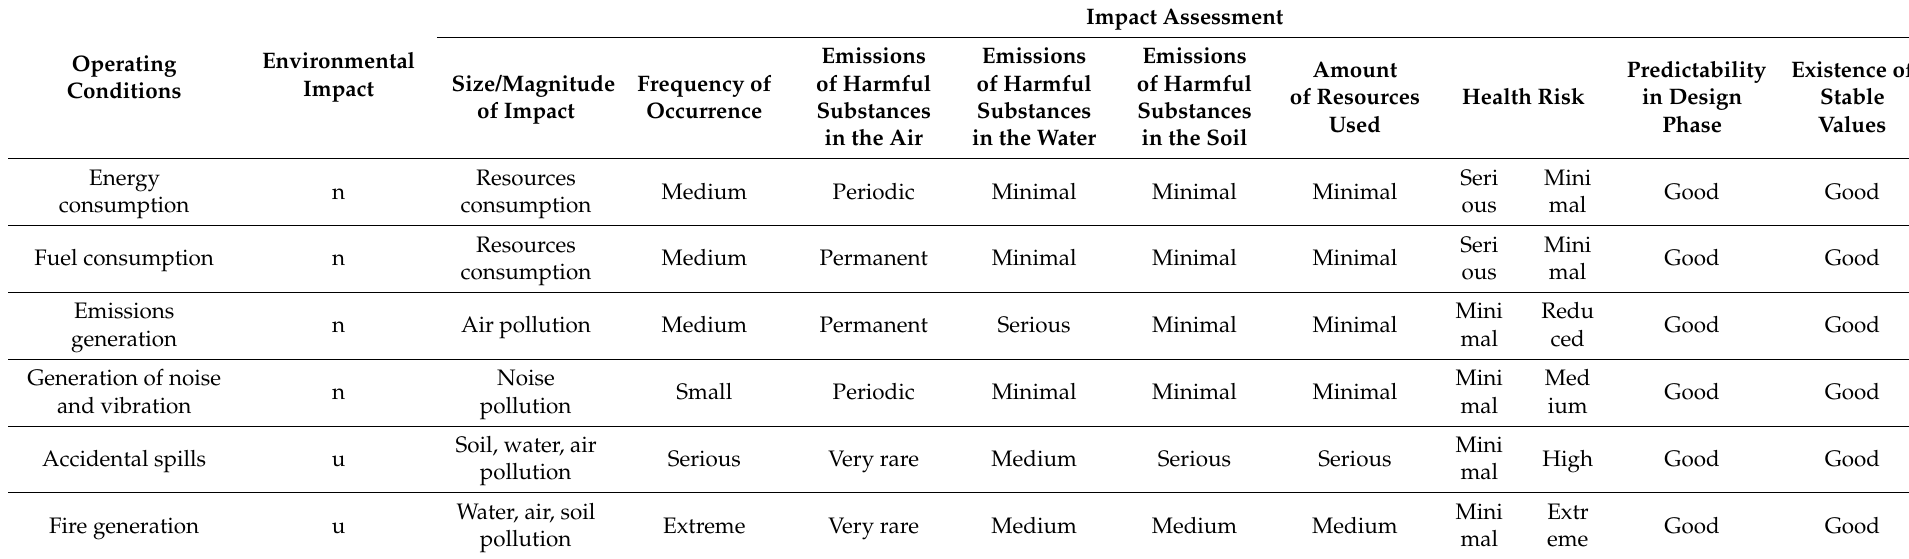
Table 4. Impact assessment of environmental